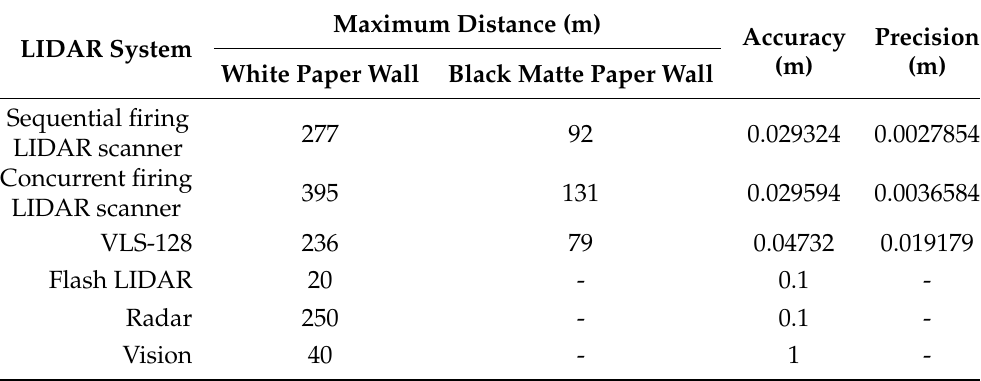
Figure 14. Received signal strength indicator and maximum distance of the three LIDAR system. “SeqLIDAR” indicates the previously proposed sequential LIDAR scanner [25]; “ConLIDAR” is the concurrent transmission scanning LIDAR proposed in the current study; while “VLS-128” refers to the Velodyne VSL-128 LIDAR. Table 6. Summary of the accuracy and precision of the three LIDAR systems with other relative positioning detection